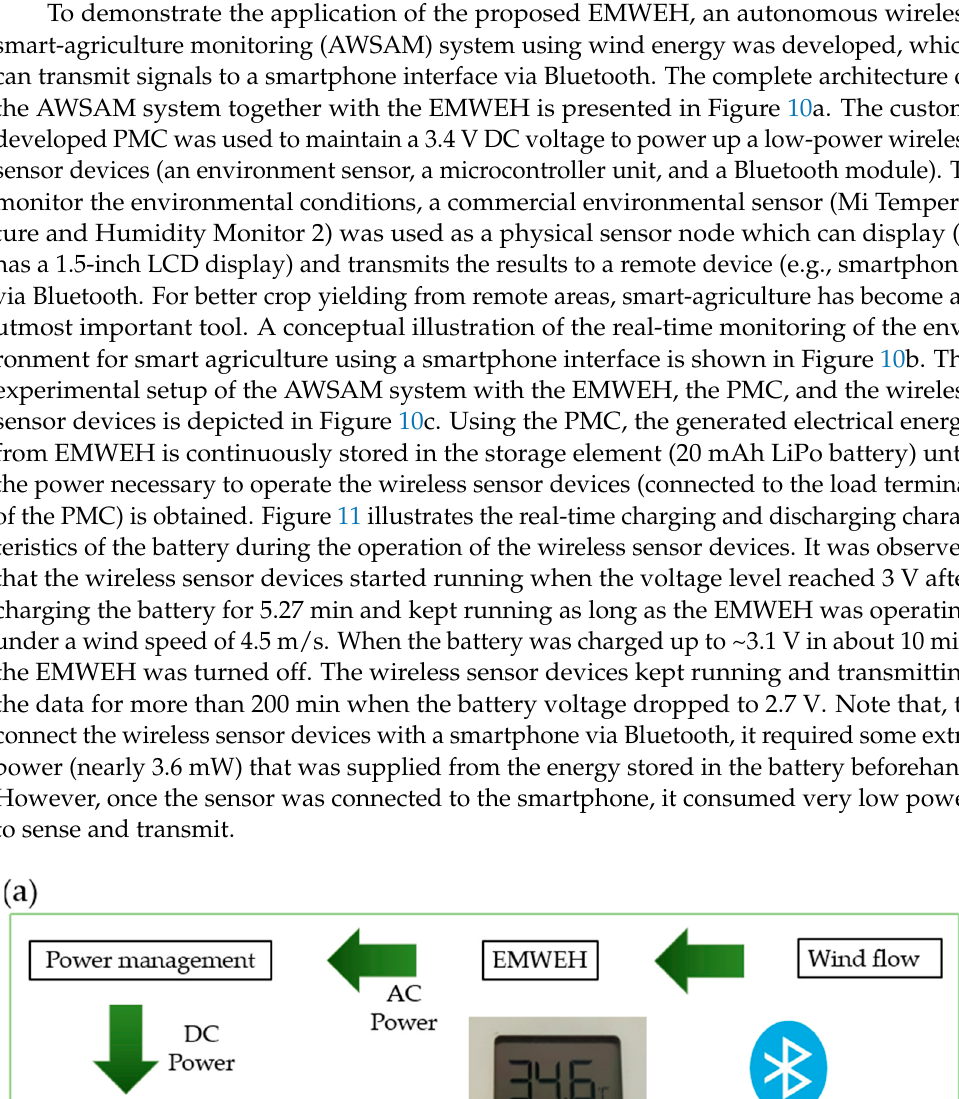
Figure 11. Real-time charging and discharging characteristics of the battery during the operation of the wireless sensor devices. 5. Conclusions In this article, we designed, fabricated, and successfully demonstrated a magnetic pole-pair-based electromagnetic rotational wind energy harvester to harvest energy from the ambient environment for wireless sensor applications. The electromagnetic transducer of the harvester was optimized to maximize the magnetic flux linkage between the magnet pole-pairs and series-connected coils for higher performance. A fabricated prototype har- vester was tested in the laboratory setup under controlled wind flow conditions. At 4.5 m/s wind speed, it can generate 2.75 V peak-to-peak open-circuit voltage. At the same